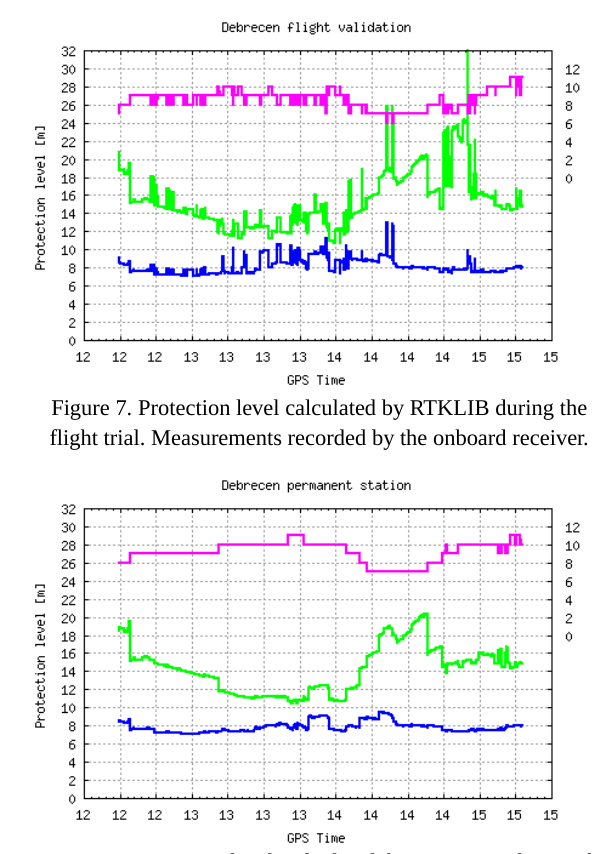
Figure 8. Protection level calculated by RTKLIB during the flight trial. Measurements recorded at the permanent station in